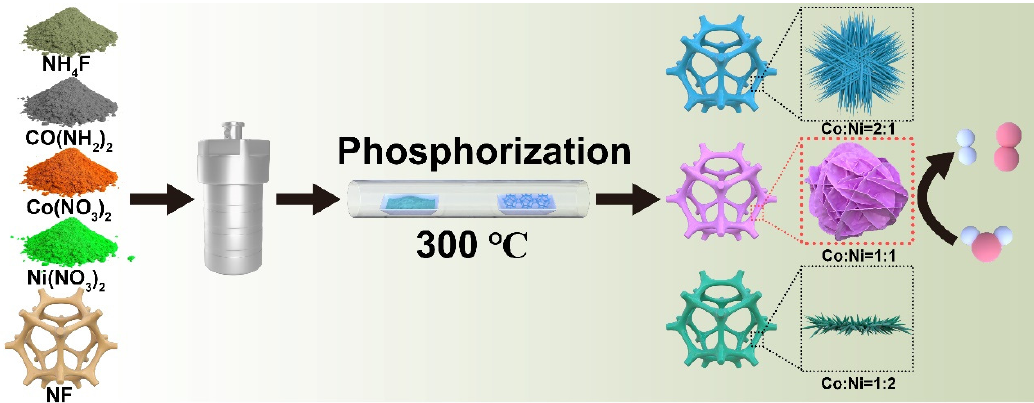
Figure 1. Schematic diagram of the fabrication of CoNiP/NA/NF nanowires.